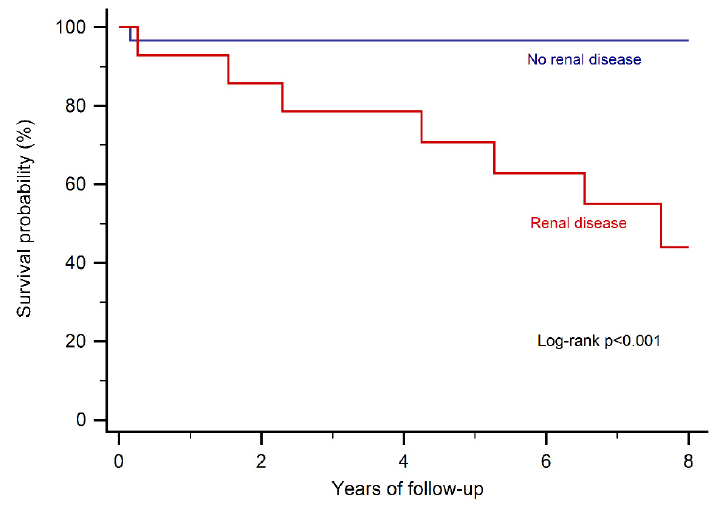
Figure 1. Kaplan–Meier curves stratifying patients according to the presence of renal disease. The most common comorbidities at baseline were thyroid dysfunction ( n = 27 (55.1%), out of these hypothyroidism n = 25, hyperthyroidism n = 2) and renal disease ( n = 15 (30.6%), (Table 2). At baseline, five patients (10.2%) had a protein losing enteropathy, two patients (4.1%) had a history of infective endocarditis, 13 patients (26.5%) had a history of a cerebrovascular accident (CVA), four patients (8.1%) had a history of an abscess (three brain and one lung), two patients (3.9%) had a history of systemic emboli (4.1%) and nine patients (18.4%) had a history of venous thrombosis (four deep vein thrombosis, four atrial thrombi and one valve thrombosis). Altogether, 49 admissions for heart failure in 35 patients were recorded. Table 2. Comorbidities at baseline, n (%).